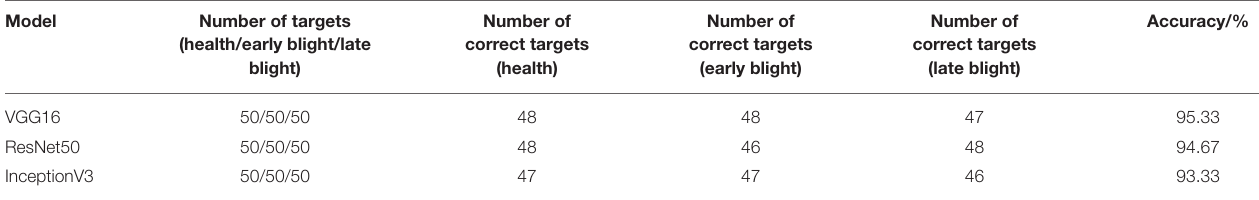
TABLE 3 | Test results of the classification